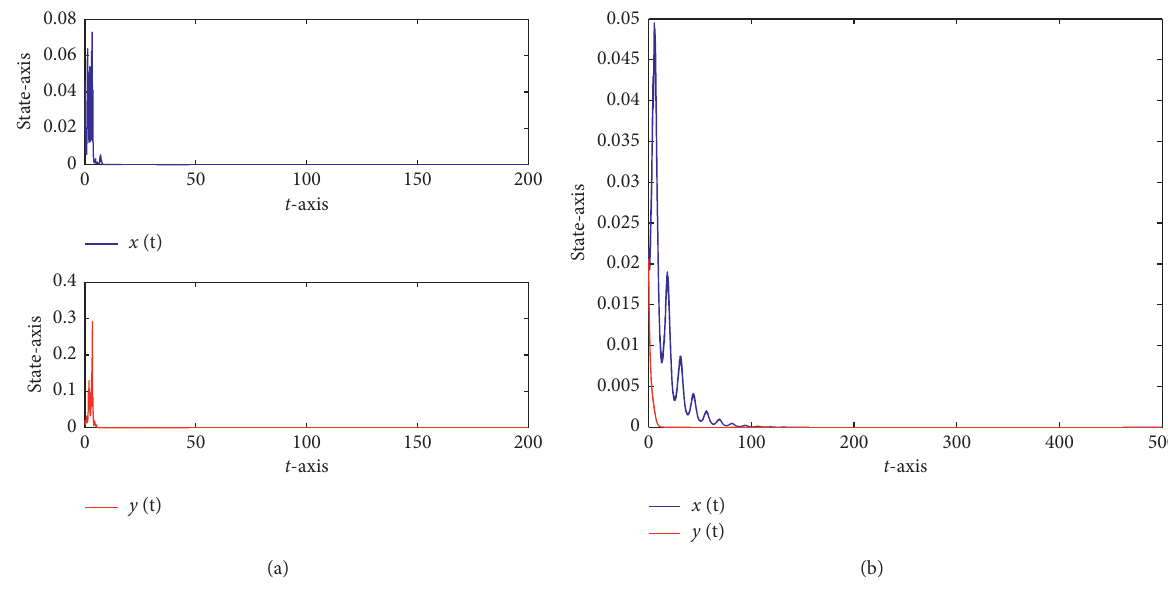
Figure 4: The extinction of all species of system (5) with n � 1 and x ( 0 ) � y ( 0 ) � 0 . 02. (a) The extinction of x and y with ( t ) � 1 . 5 + 0 . 02sin ( t /2 ) , σ ( t ) � 1 . 2 + 0 . 01sin ( t /2 ) . (b) The extinction of x and y with ξ σ 1 2 ) ,t � 0 . 1 k,k ∈ N . + 0 . 01 sin ( t k /2 k